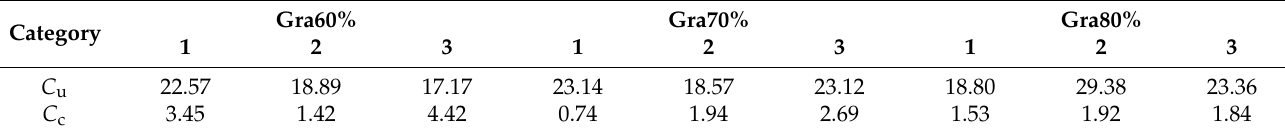
Table 5. Uniformity coefficients and curvature